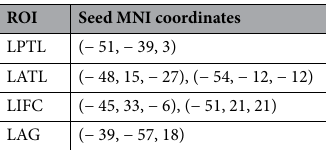
Table 1. MNI coordinates of ROI